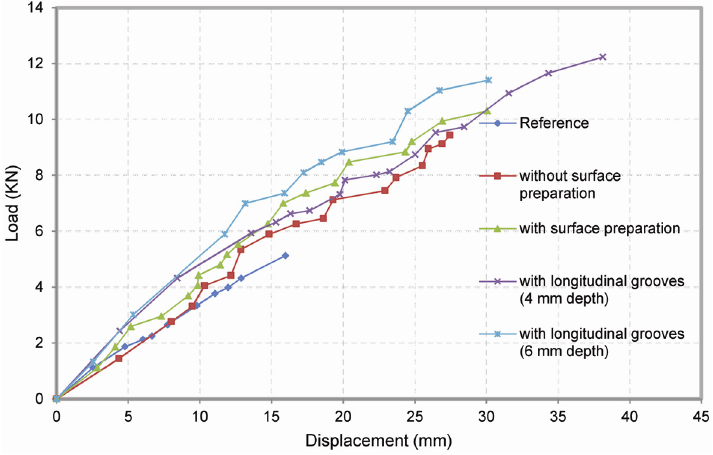
Fig. 21. Comparing the curves of load-displacement in reinforced specimen with two layers of